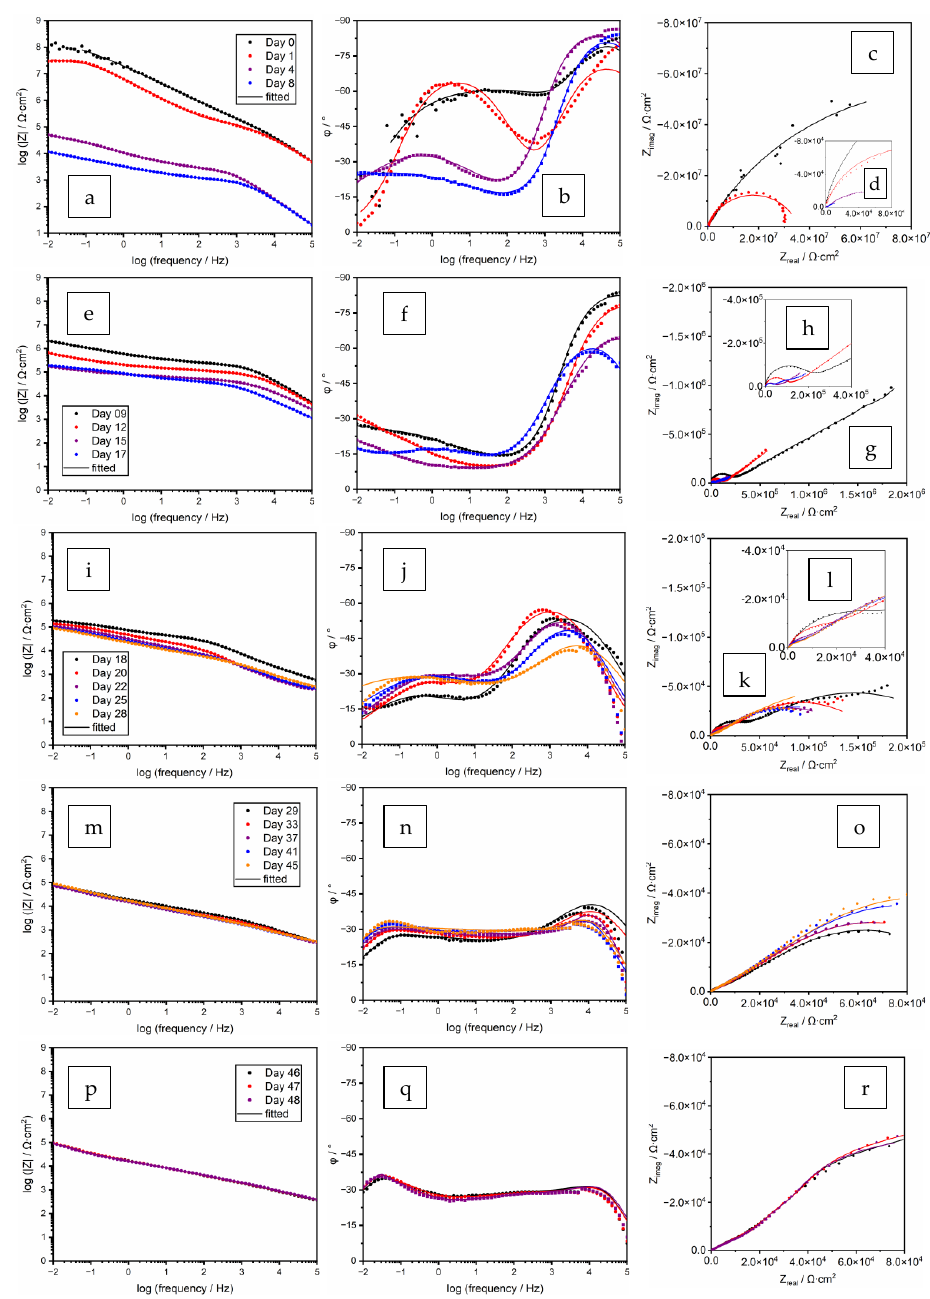
Figure 9. Original and fitted EIS spectra of a coating prepared from the formula Zn–80%-PC. ( a – d ) Days 0–8; ( e – h ) Days 9–17; ( i – l ) Days 18–28; ( m – o ) Days 29–45; ( p – r ) Days